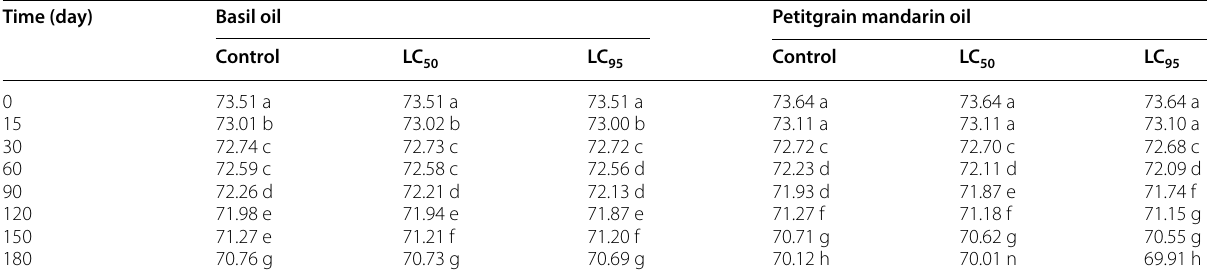
Table 8 Effect of basil and petitgrain mandarin oils on total carbohydrates contents in wheat grains during storage (0–180 days) Time (day)